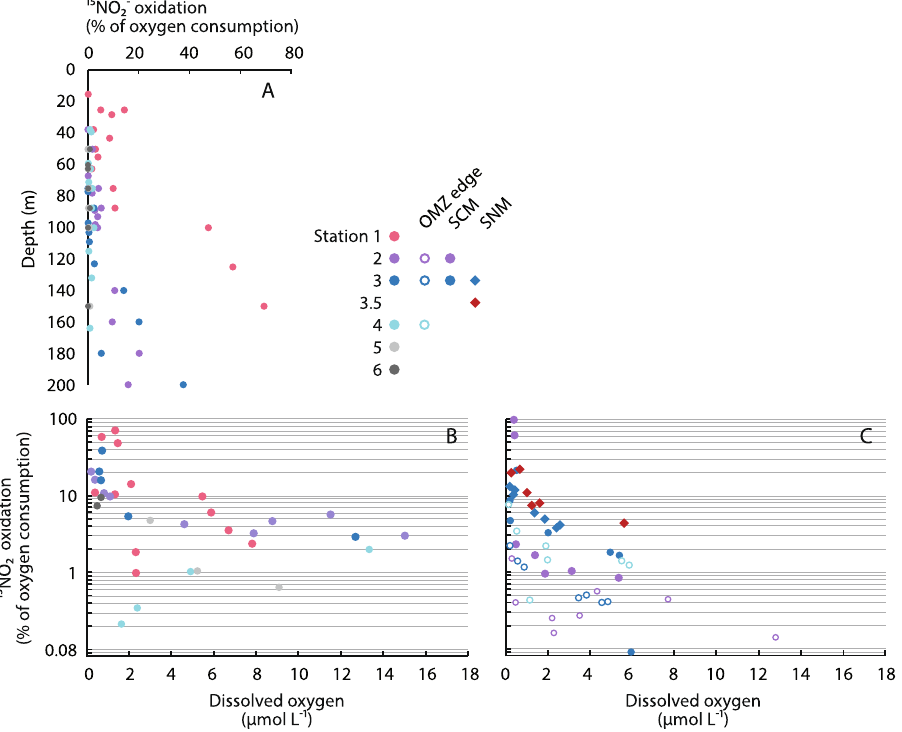
Fig. 3 Oxygen consumption via nitrite oxidation. The percentage contribution of nitrite oxidation to overall oxygen consumption rates (OCR) with A depth, and as a function of average dissolved oxygen (DO) in B depth pro fi les and C oxygen manipulation experiments. Colors denote different stations. Only measurements for DO < 18 µ M are included in panel B , and all experimental bottles with dual nitrite oxidation and OCR are shown in ( C ). In panel C , different symbols denote experiments conducted in different regions of the water column, with two experiments conducted at Station 2 (oxygen minimum zone [OMZ] edge, open purple circles; secondary chlorophyll maximum [SCM], fi lled purple circles), three at Station 3 (OMZ edge, open dark blue circles; SCM, fi lled dark blue circles; secondary nitrite maximum [SNM], dark blue diamonds), and one each at Stations 3.5 (SNM, red diamonds) and 4 (OMZ edge, open light blue